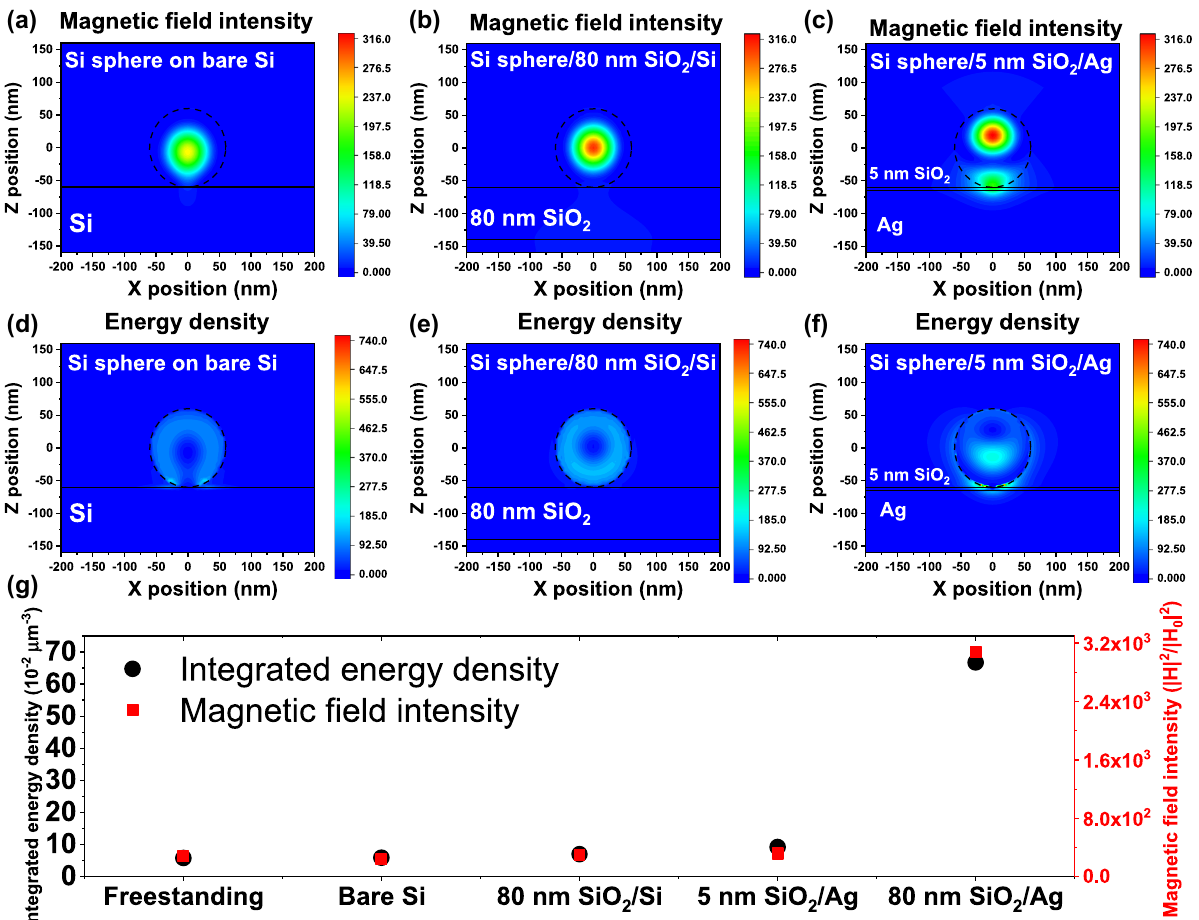
Figure 3: (a–c) Magnetic field intensity and (d–f) energy density distributions in Si spheres on various substrates: (a, d) on bare Si, (b, e) /Si (c, f) 5 nm SiO thin-film cavity. (g) Integrated energy densities and magnetic field intensities of Si spheres on various 80 nm SiO 2 2